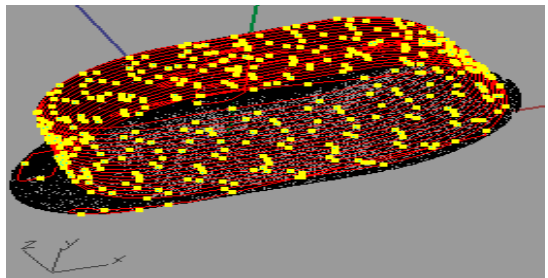
Figure 10. Spray trajectory of point cloud patch in Z-axis direction.